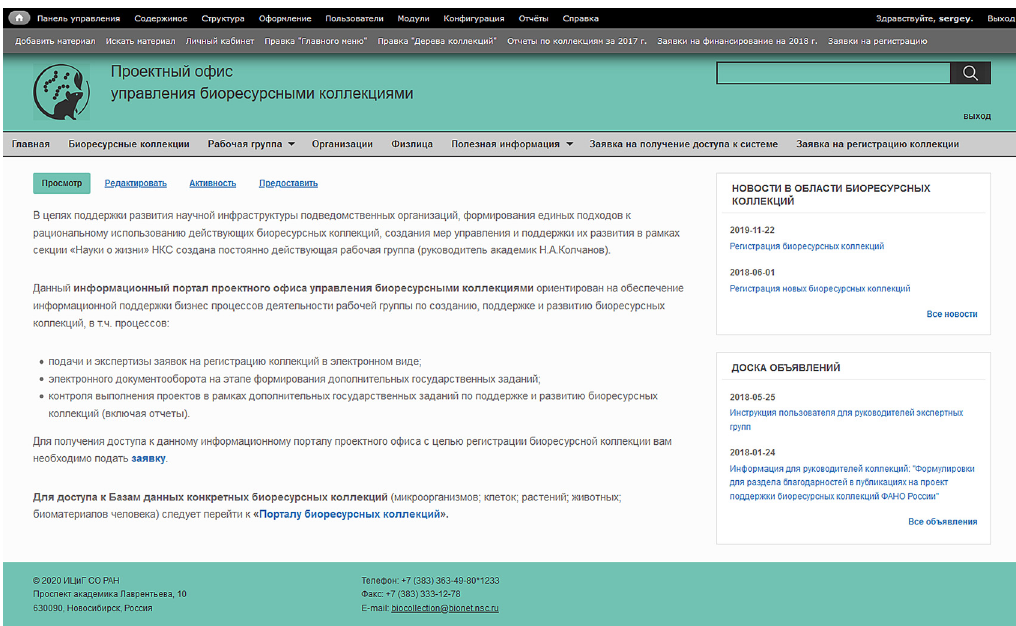
Figure 1: The main page of the project office, where the base information sections are visible – collections, organizations, individuals,documents.There are service functionsonthe top linethat differ for users depending on their roleinthe projectof fi ce.